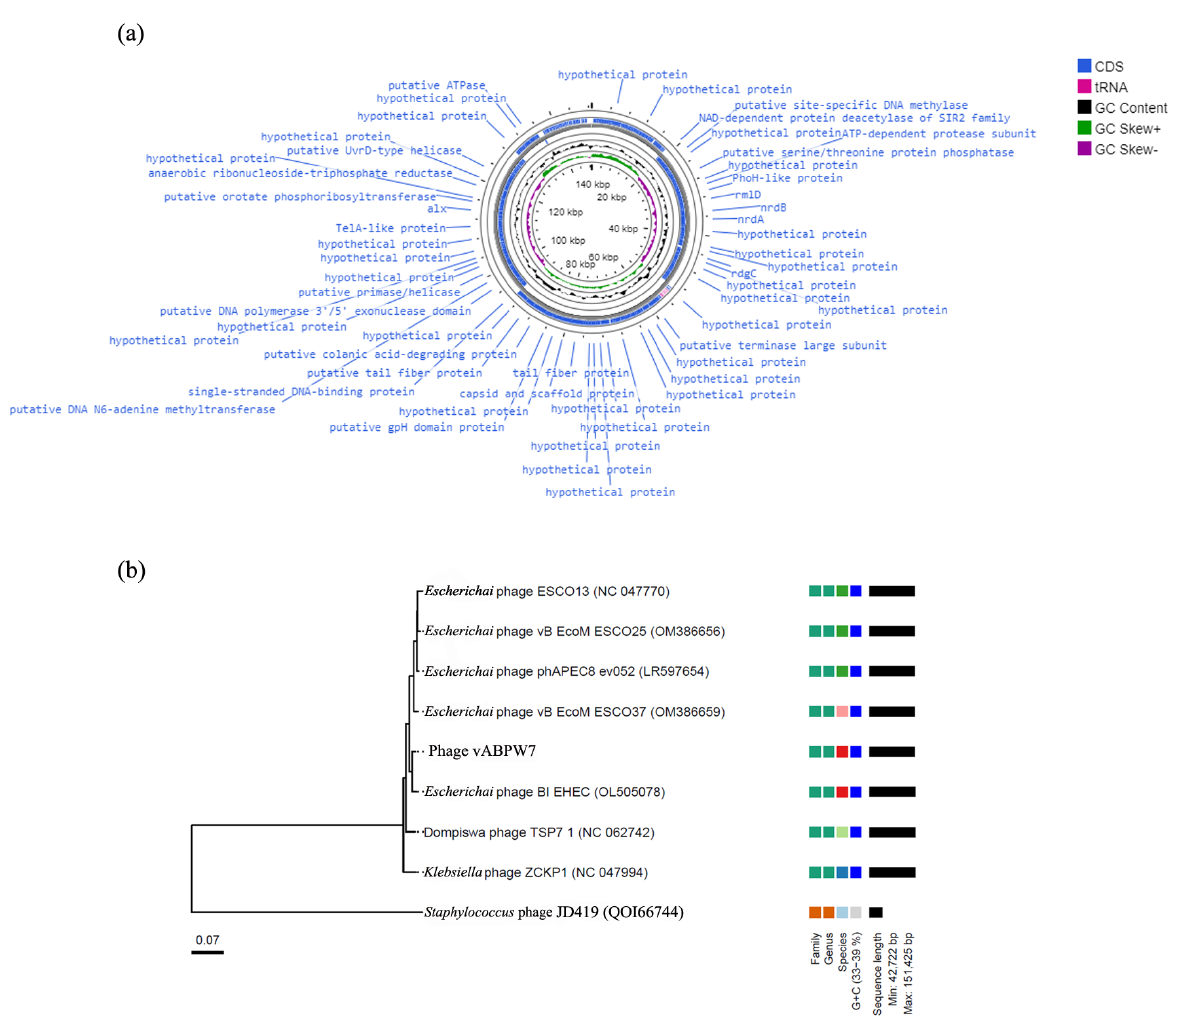
Figure 4. Phage genome characterization. ( a ) Circular genome map of phage vABPW7. The graphical map of the genome was generated using GC viewer server Beta . ( b ) Phylogenetic tree analysis of the whole-genome sequence of phage vABPW7 and related phages. The phylogeny was assessed by the VICTOR program. Staphylococcus phage JD419 (QOI66744) was used as an outgroup.